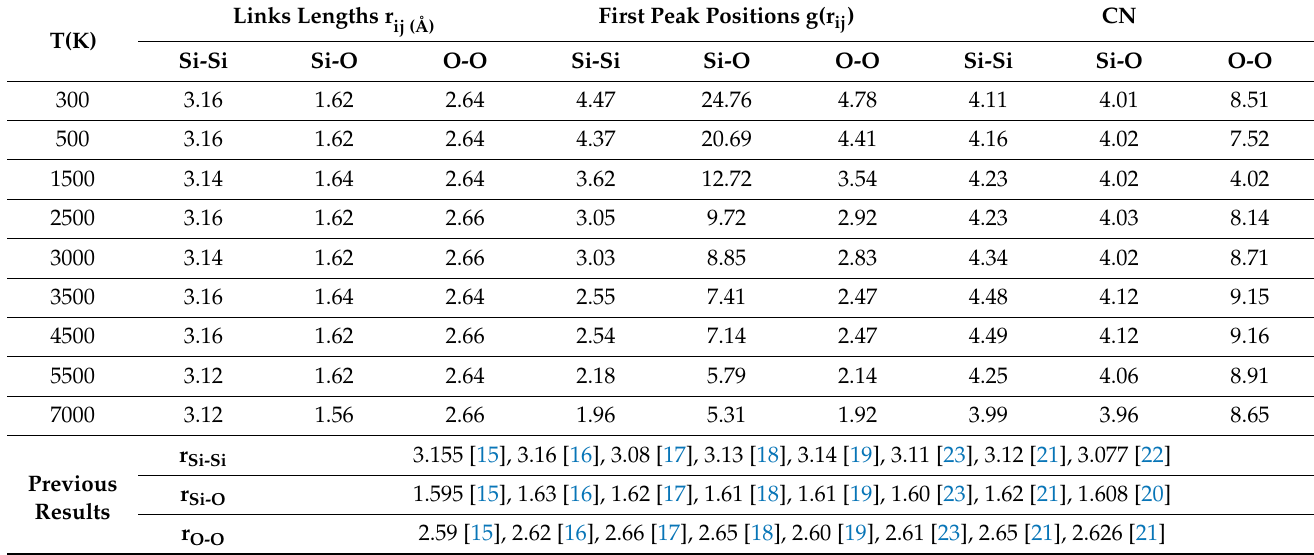
Table 3. The number of structural units and link angles of bulk SiO 2 at different T values.